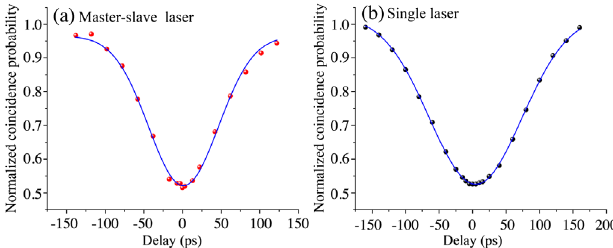
FIG. 6. Hong-Ou-Mandel interference between two gain- switch lasers using different laser sources. (a) A dip with visibility 48.4% is obtained with master-slave laser using laser-seeding technology. (b) The achieved visibility is 47.4% with single laser source together with spectral